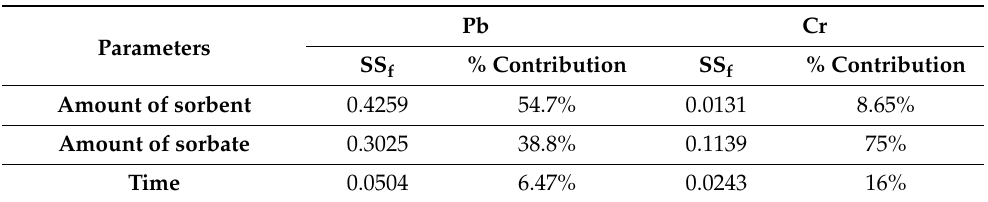
Table 4. Percentage contribution of selected process variables towards % sorption of Pb and Cr on defatted seed residue of C.